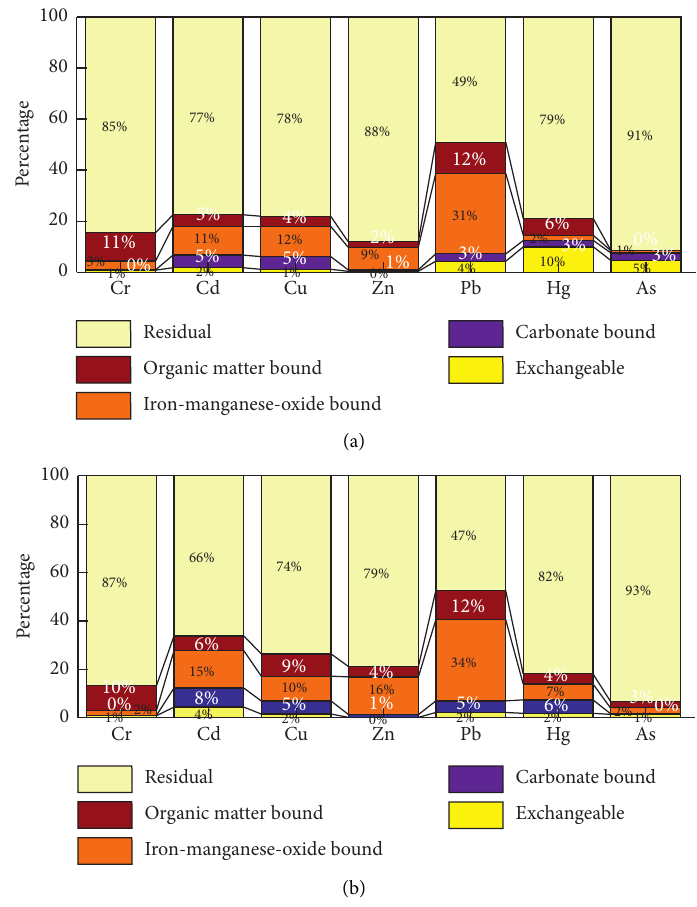
Figure 4: Concentration of heavy metal speciation in soil at the before sowing (a) and harvesting (b) periods of rice.